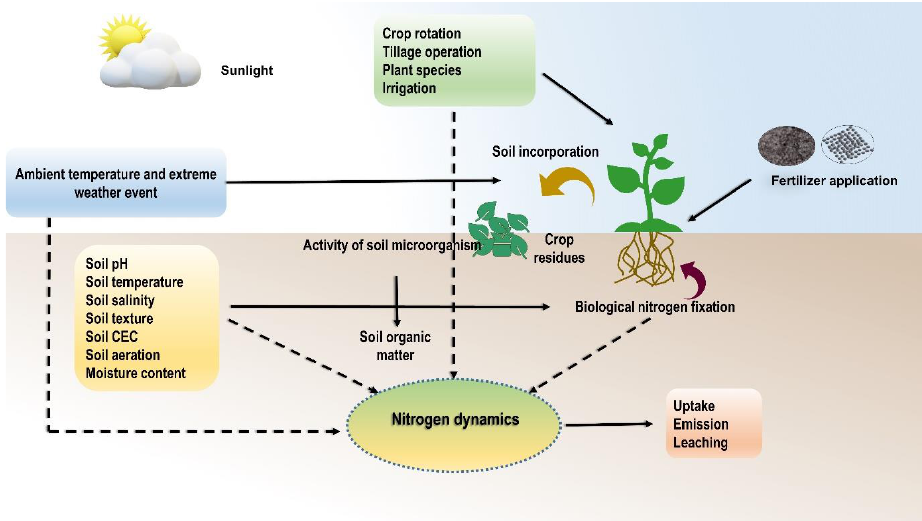
Figure 5. Interactions between nitrogen dynamics and environmental factors.